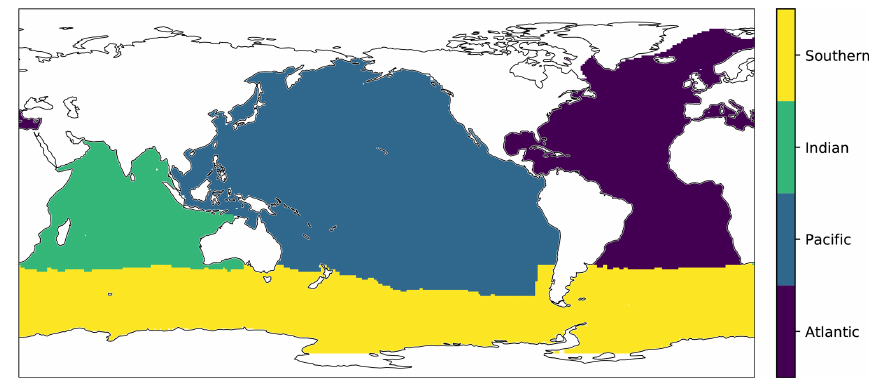
Figure A4. Ocean basin boundaries used in Table 5 as used by the RECCAP2 project (https://reccap2-ocean.github.io/regions/, last access: 21 November 2020). The Southern Ocean and North Atlantic boundaries are defined by biome boundaries defined in Fay and McKinley (2014).